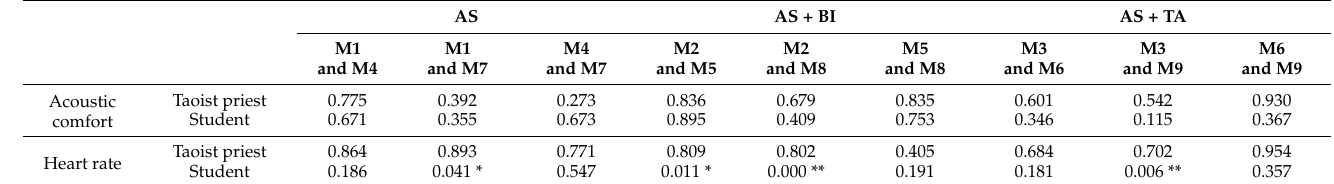
Table 2. Significant differences for acoustic comfort and heart rate of Taoist priests and ordinary people between two different scenes of Laojundong temple under the same sound, emerging from Kruskal–Wallis test and ANOVA for repeated measurement test, respectively (* p < 0.05, ** p < 0.01) (AS: Ambient sound, BI: Bird sound, TA: Taoist music).